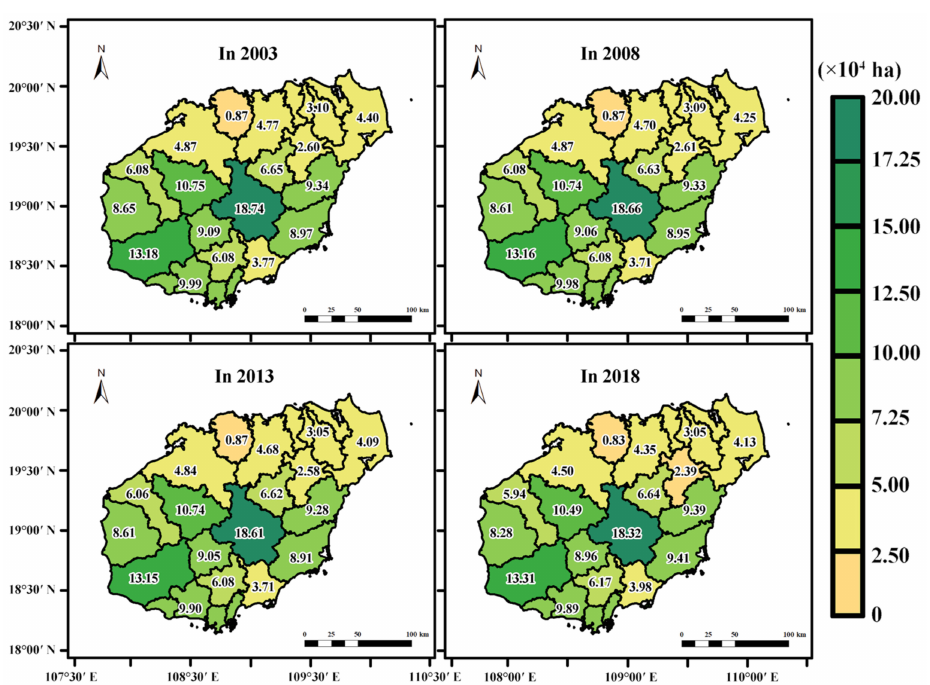
Figure 8. Distribution of Forestland area in different cities and counties in Hainan Island from 2003 to